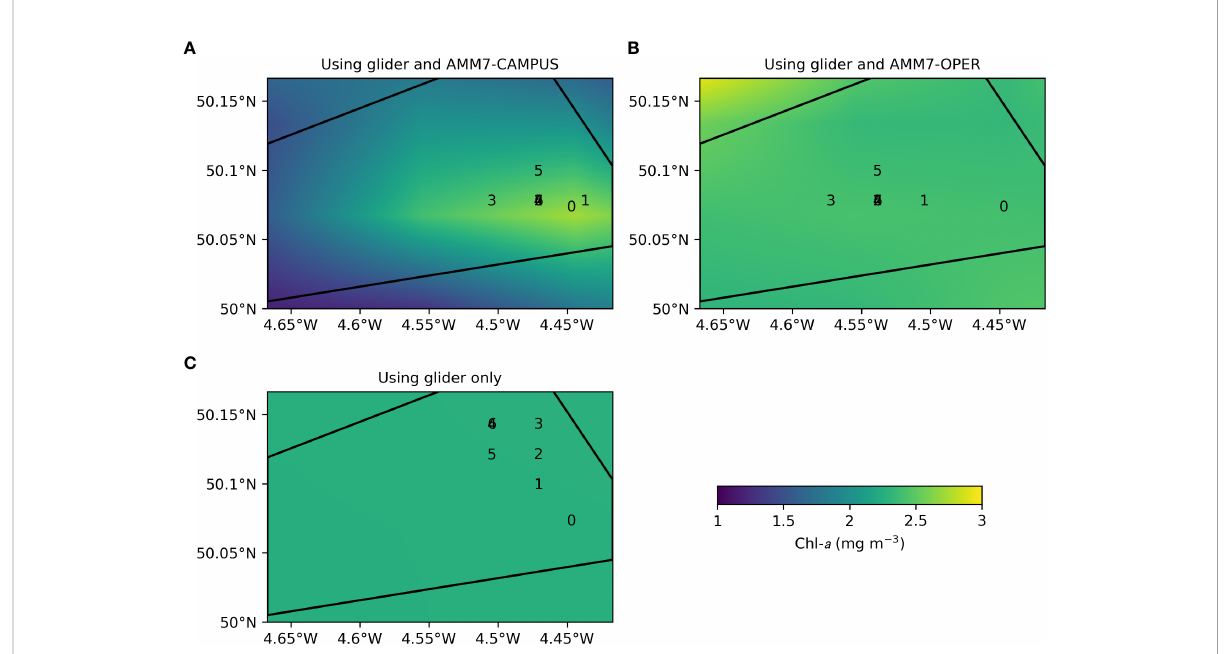
FIGURE 11 24-hour chl- a predictions for 20:05 on 14 May 2021 from STOCHASTIC using different model chl- a inputs: (A) glider and AMM7-CAMPUS, (B) glider and AMM7-OPER, (C) glider only. The black lines denote the region the glider was constrained to stay